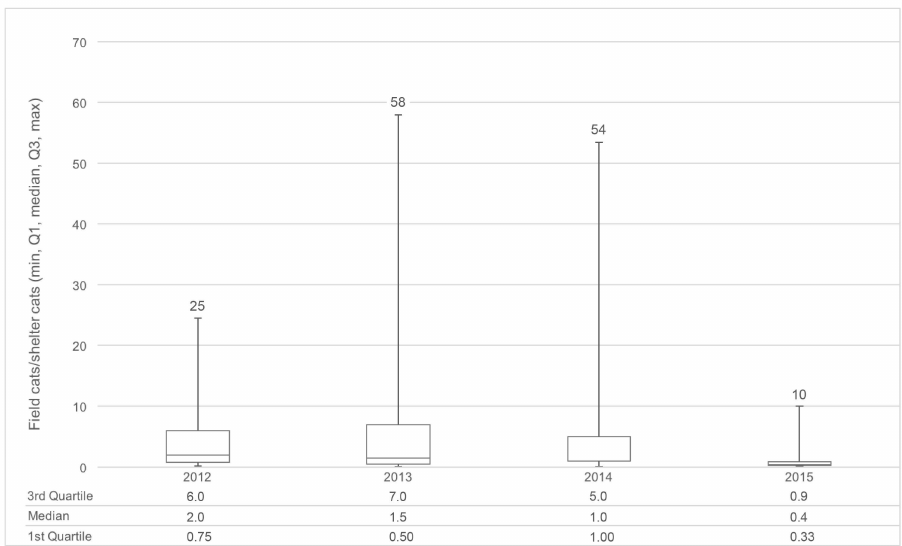
Figure 4. Descriptive statistics (minimum, maximum, median, first and third quartiles) illustrating the impact of “Red-Flag Cat Model” for each program year. For each cat originating as a “shelter intake,” additional “field-origin” cats from the same location were often trapped, sterilized, vaccinated, and